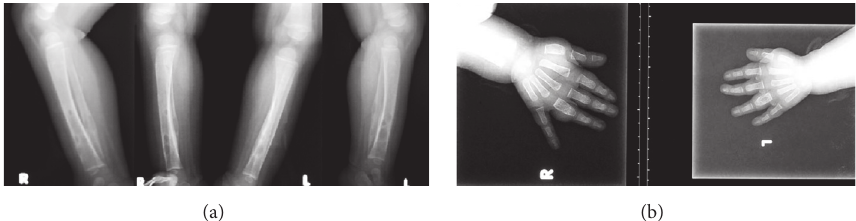
Figure 2: Disseminated Bacillus Calmette-Gu´erin (BCG) infection of the upper and lower extremities in an infant produces similar images (June–September 2012). (a) Bilateral lateral and anteroposterior conventional radiographs of the lower parts of both legs show multiple radiolucent cystic lytic areas of bone destruction with minimal periosteal reaction and bone widening in the distal diaphysis of tibia and fibula. (b) Conventional posteroanterior radiographs of both hands revealed periosteal elevation and multiple small lytic lesions with bone widening in the proximal phalanges of the fourth fingers